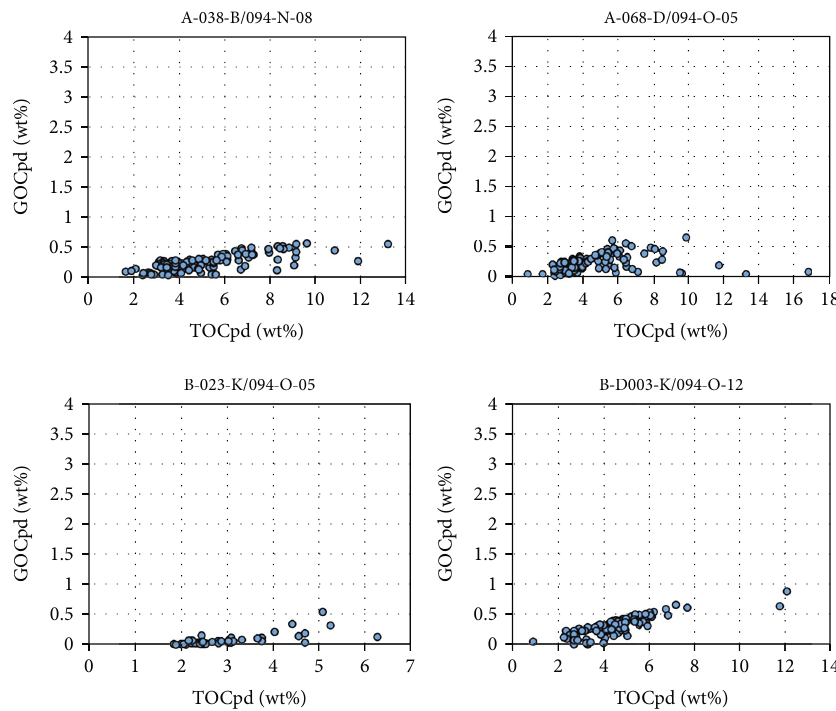
Figure 6: Correlation between calculated GOCpd and measured TOCpd of A-038-B/094-N-08 [17] and A-068-D/094-O-05 [18], and B-023- K/094-O-05 [19] and B-D003-K/094-O-12 [19] GOCpd shows a relatively very small weight percent (wt%) compared to TOCpd and is less than 1 wt% in four boreholes.